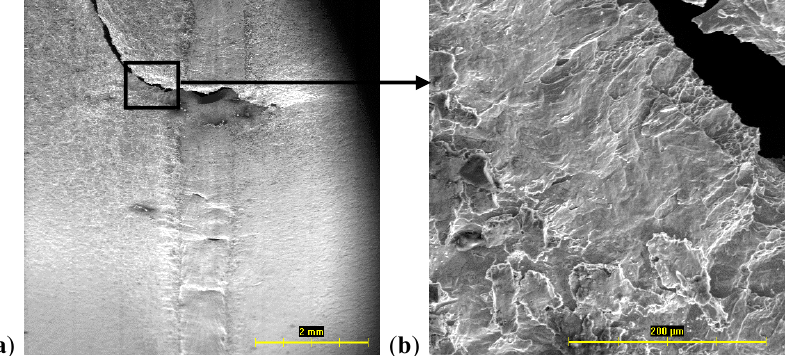
Figure 12. Failure of TWB1 after the Erichsen test. ( a ) The initiation and propagation of the failure. ( b ) Fracture surface.